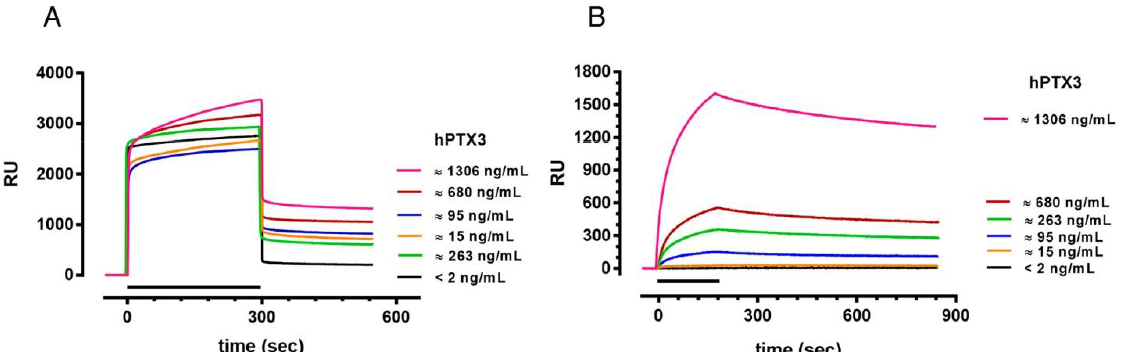
Figure 4. SPR-based immunoassay for PTX3 detection in human plasma. ( A ) Sensorgrams obtained injecting plasma samples, diluted five-fold with PBST, from subjects with different levels of endogenous PTX3 (determined by a classical ELISA) on the MNB4 immobilized on the sensor chip. Samples were injected for 5 min (bar) at a flow rate of 30 µL/min. ( B ) Sensorgrams obtained injecting a secondary anti-PTX3 antibody over the surfaces previously injected with plasma samples to highlight the PTX3-dependent binding signal. Samples were injected for 3 min (bar) at a flow rate of 30 µL/min. The running buffer was PBST, pH 7.4. Data are expressed as resonance units (RU) against